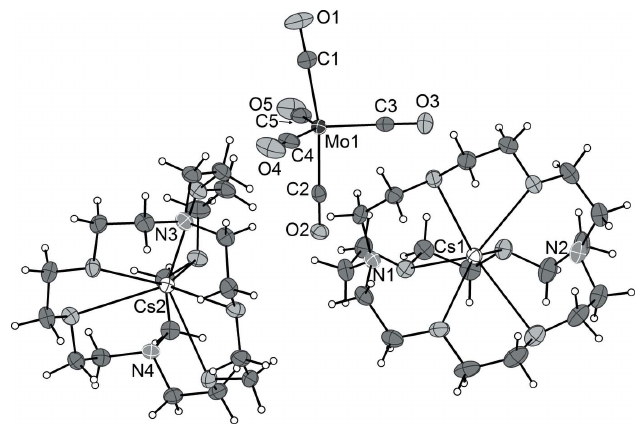
Figure 1 The asymmetric unit of [Cs([2.2.2]crypt)] 2 [Mo(CO) 5 ]. Displacement ellipsoids are drawn at the 50% probability